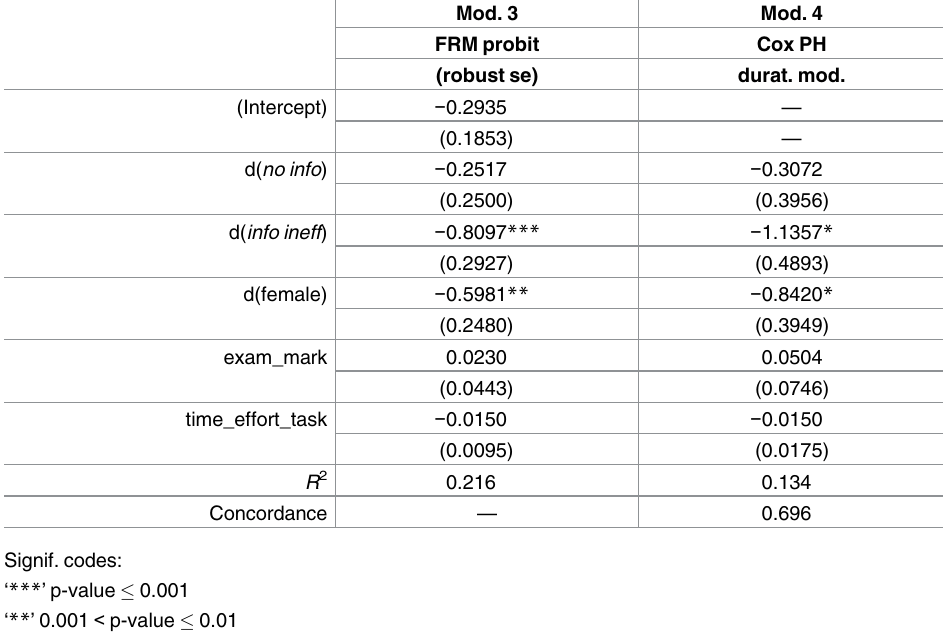
Table 3. Regressions’ estimates with s.e. in